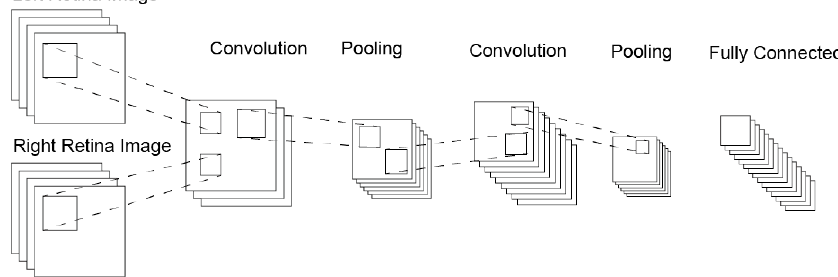
Figure 12. The Convolutional Neural Network structure of the simulation, which contains two convolutional layers, two pooling layers and a fully connected